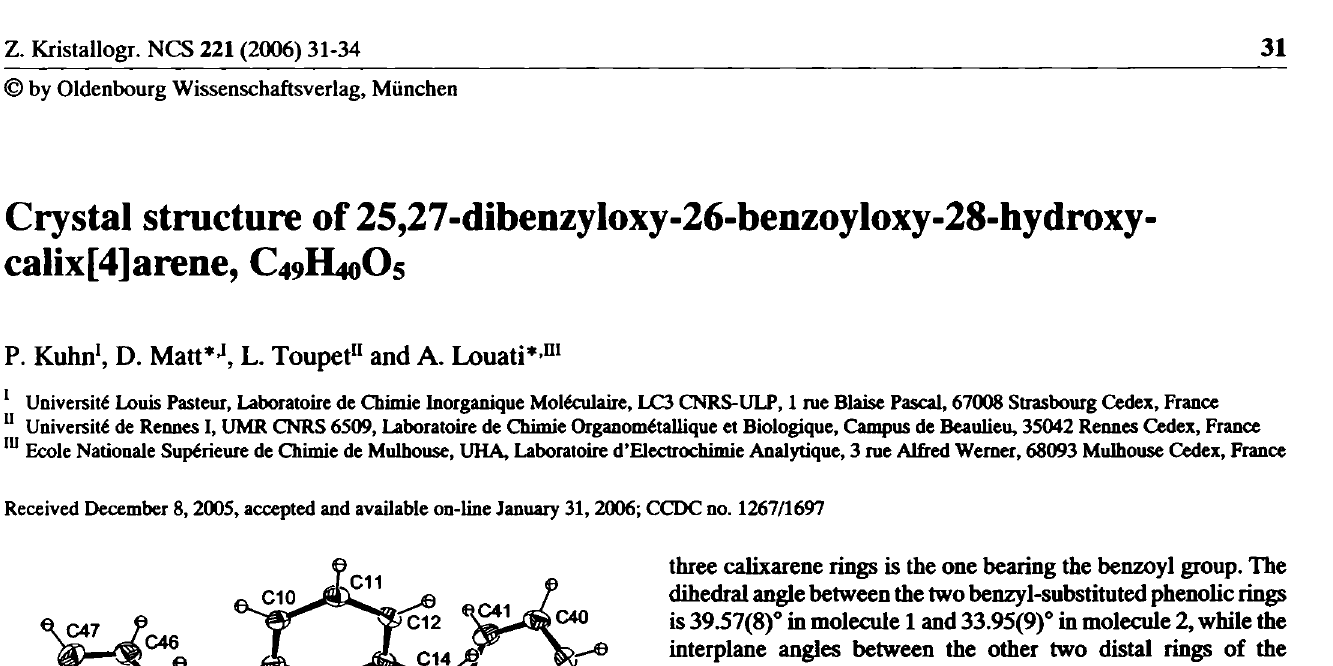
Table 1. Data collection and handling.